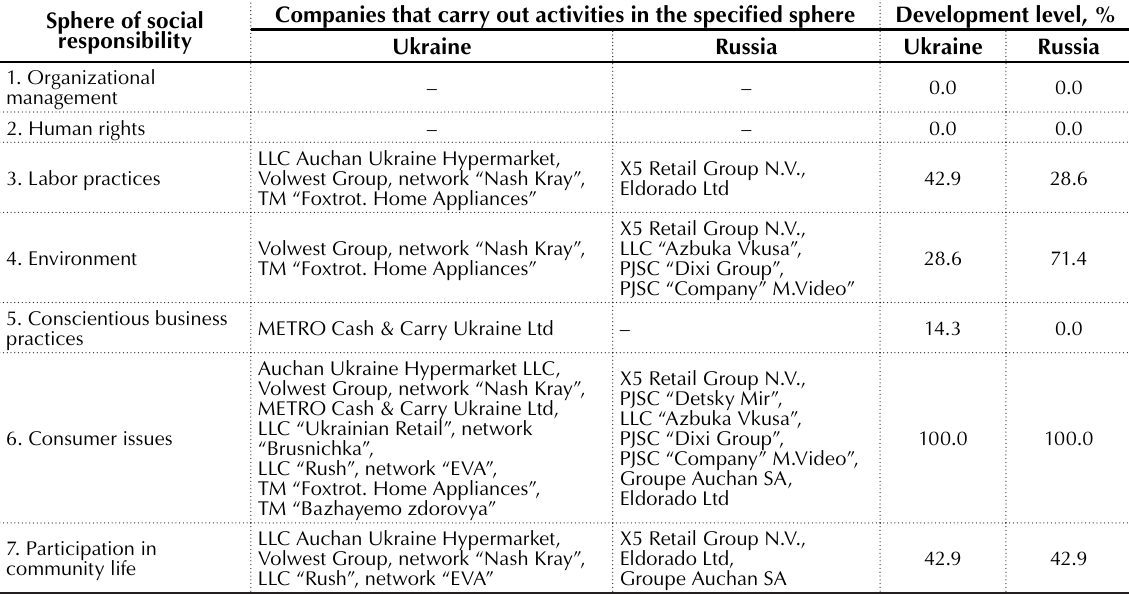
Source: compiled by the authors according to Tables 1 and